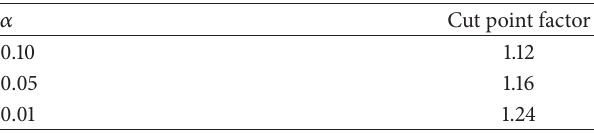
Table 3: Estimation of cut point factor based on different false positive rates ( 𝛼 ). Cut point factor (CPF) calculated at different false positive rates based on the within monkey variability observed across 4 biotherapeutics. This generic CPF can be used to establish the floating individual cut point signal according to each cynomol- gus monkey baseline signal.